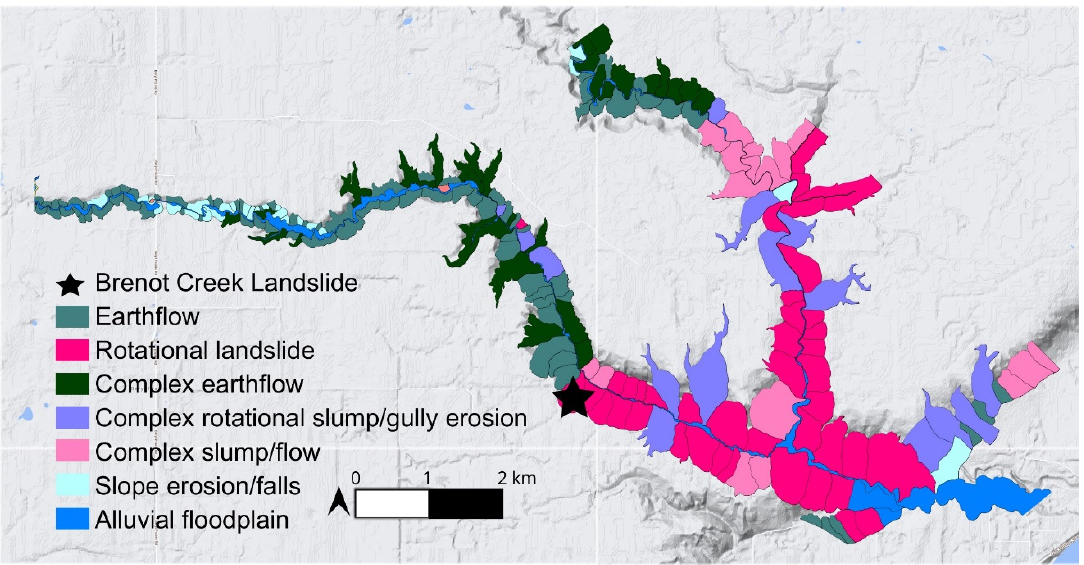
Figure 7. Geomorphically annotated LiDAR for the Lynx Creek and Brenot Creek Tributaries depicting the pervasive nature of various landslide scars. Rotation landslides, such as the Brenot Creek Landslide are shown in magenta.